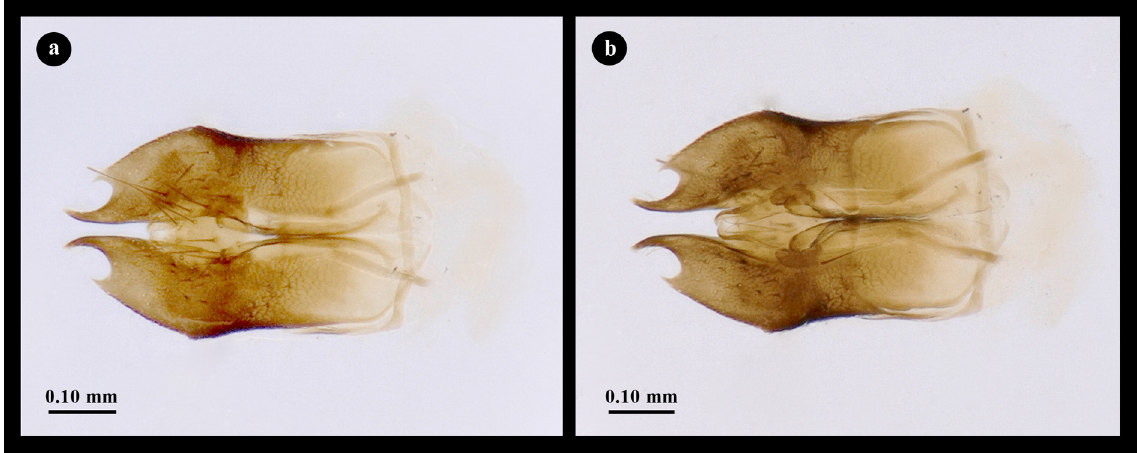
Fig. 20. Soliga ecarinata gen. et sp. nov., paratype, ♂(AIMB). a . Genitalia, dorsal view. b . Genitalia, ventral